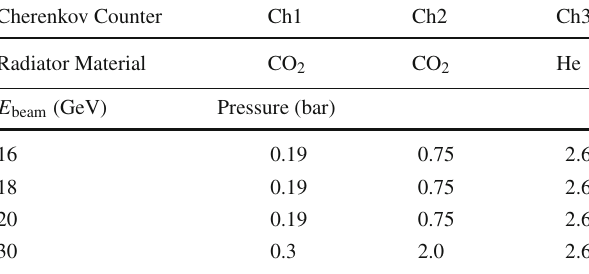
Table 1 Cherenkov radiator materials and gas pressure values set for the different beam